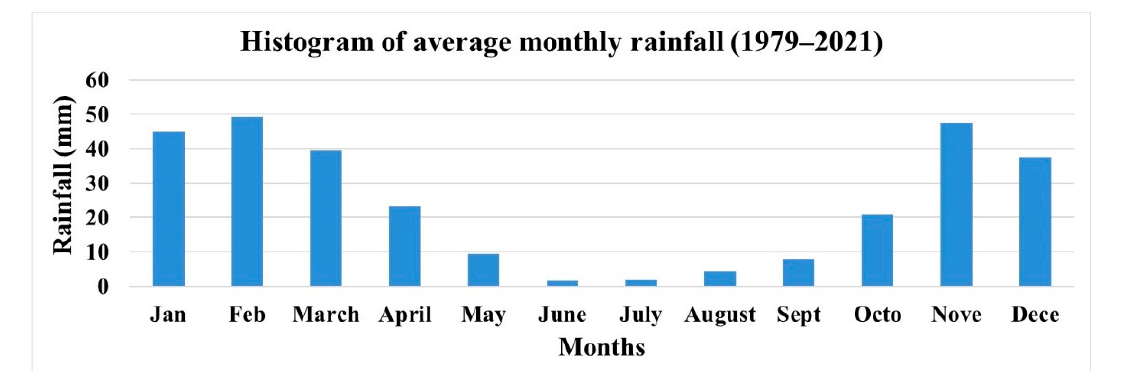
Figure 2. Histogram of the average monthly rainfall at Tafraout during (1979–2021) (According to the Souss-Massa Hydraulic Basin Agency).